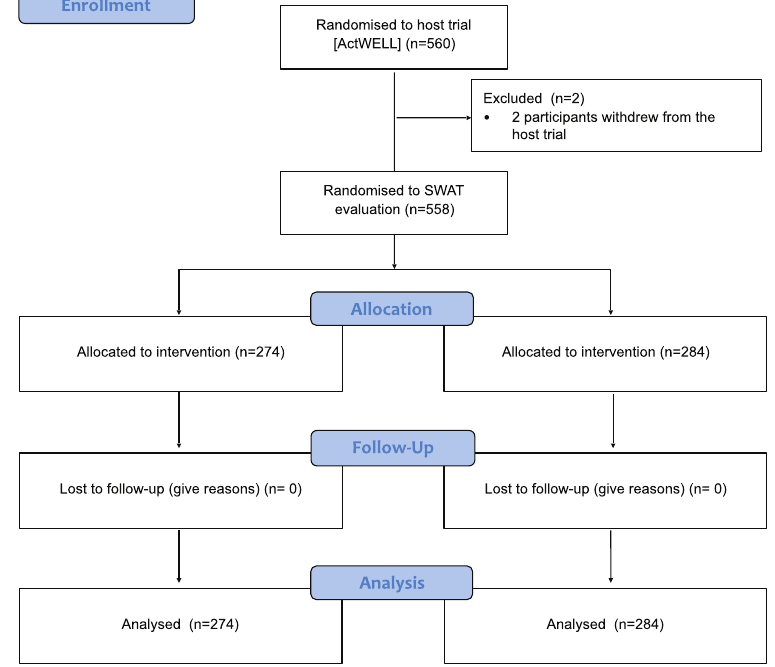
Figure 2. Flow diagram summarising the flow of participants through the SWAT